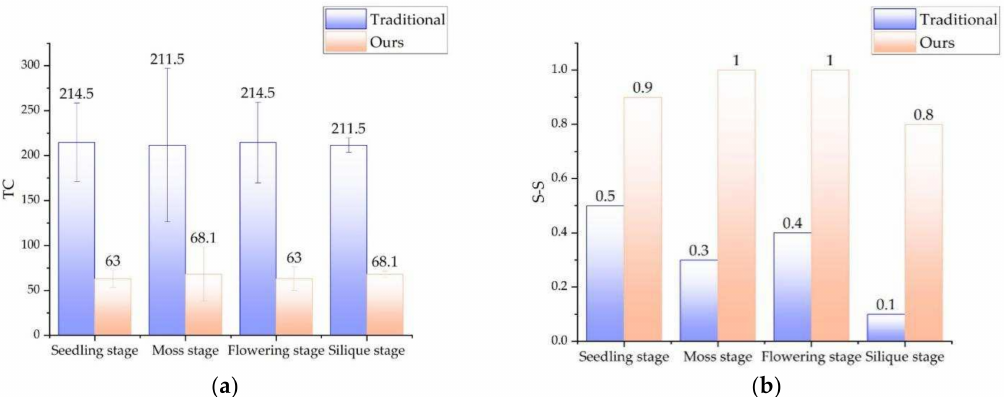
Figure 12. Comparison of the time and effect between the traditional registration algorithm and ours. ( a ) the comparison of the TC. ( b ) the comparison of the S-S. Note: TC: Time consumption (Second). S-S: succeed status (Yes or